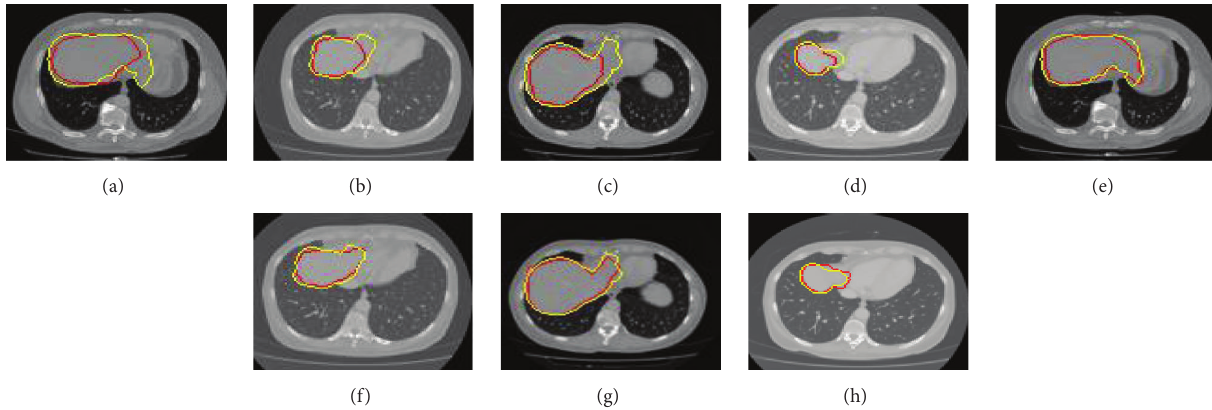
Figure 2: Segmentation results on “special slices.” Ground truth in yellow color and segmentation results in red color. (a)–(d) Segmentation with DKC (domain knowledge centric) graph-cut and (e)–(h) results of DKSI (domain knowledge and swarm intelligence) integrated graph- cut.